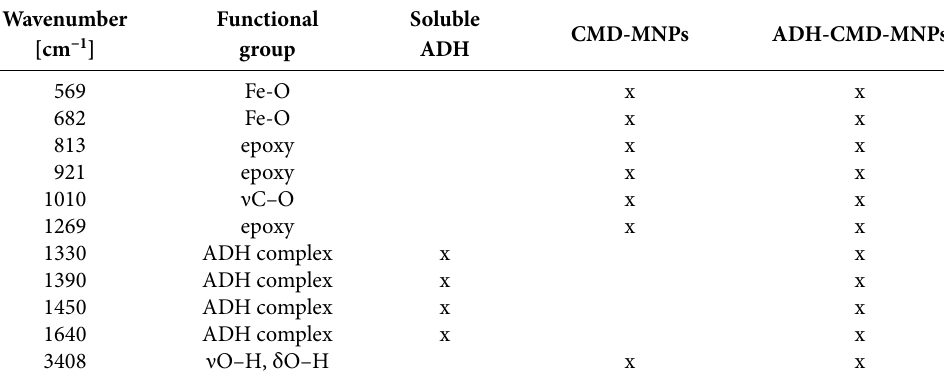
Table 3. Peaks from FT-IR spectra, present in soluble ADH, CMD-MNPs and